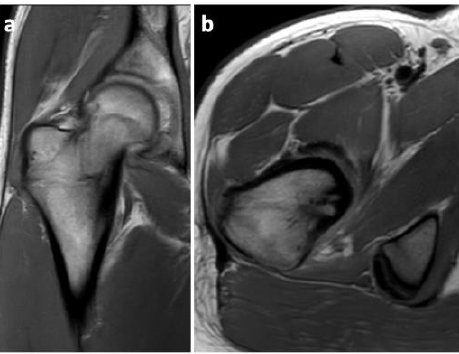
Figure 10. A 6-month post-op MRI scan showing no signs of relapse of the OO. ( a ) Frontal projection; ( b ) Transverse projection.